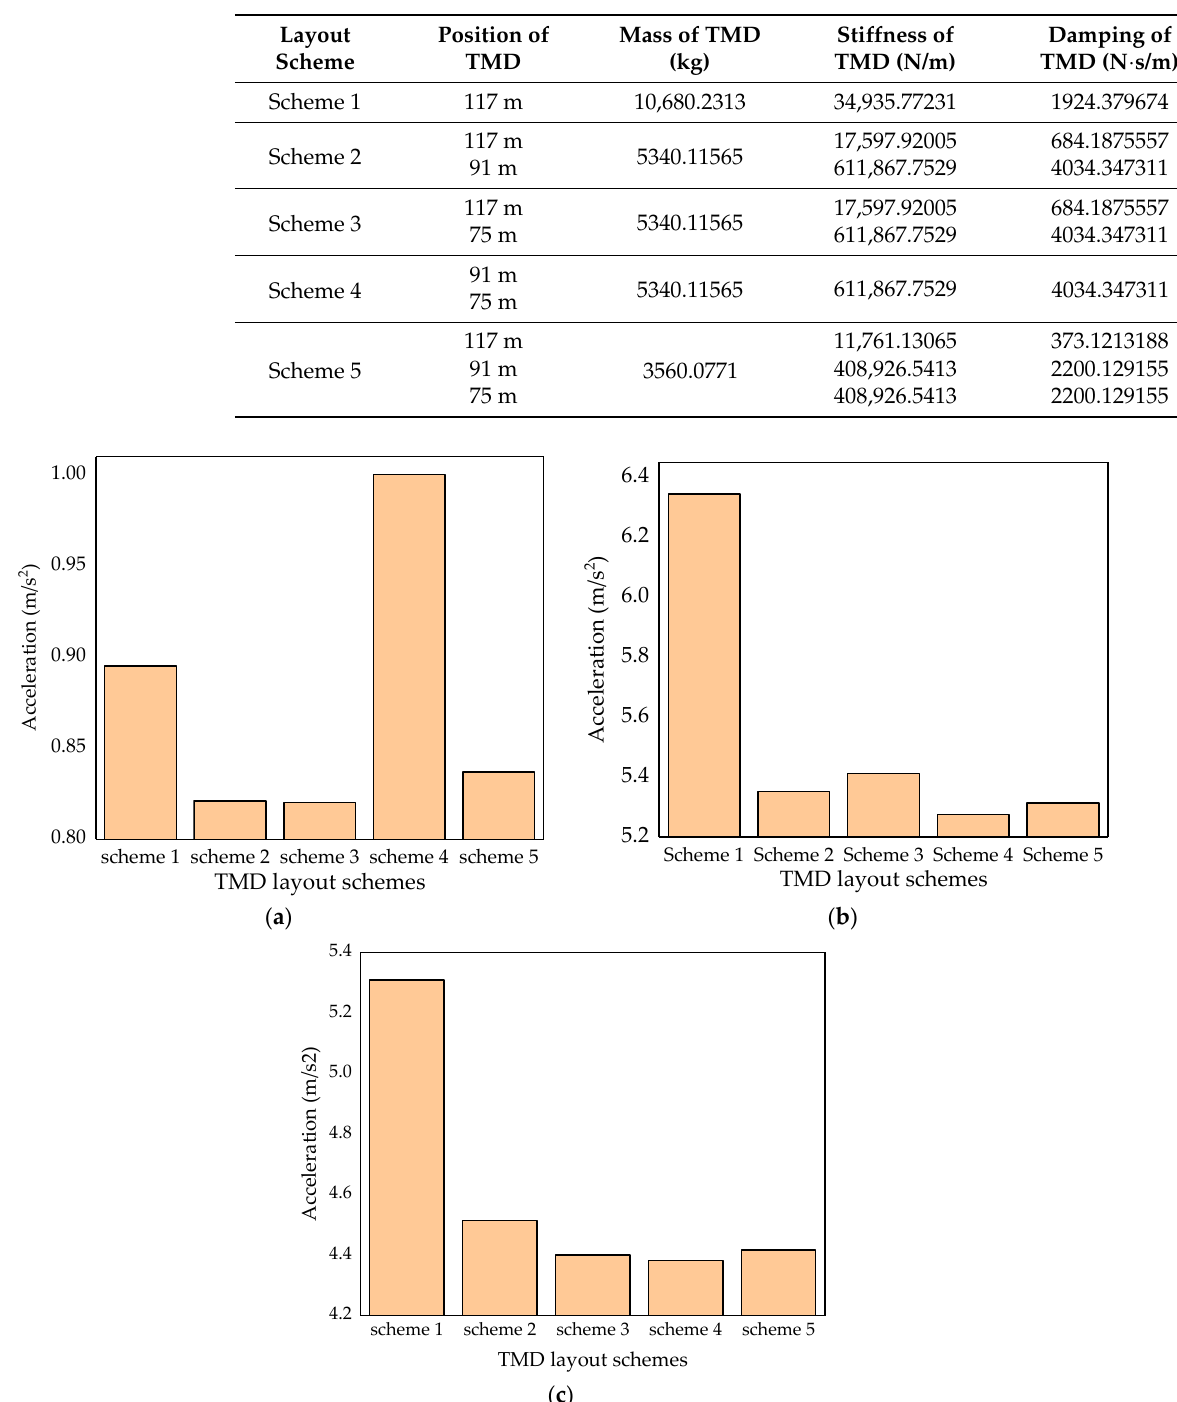
Figure 13. The acceleration of the different installation positions of TMD under various schemes: ( a ) acceleration at 117 m of the tower; ( b ) acceleration at 91 m of the tower; ( c ) acceleration at 75 m of the tower.